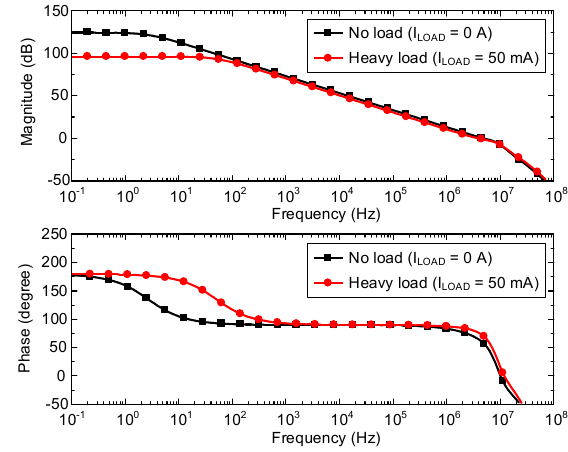
Figure 7. Simulated open-loop response of LDO at different load conditions with C L = 100 pF.